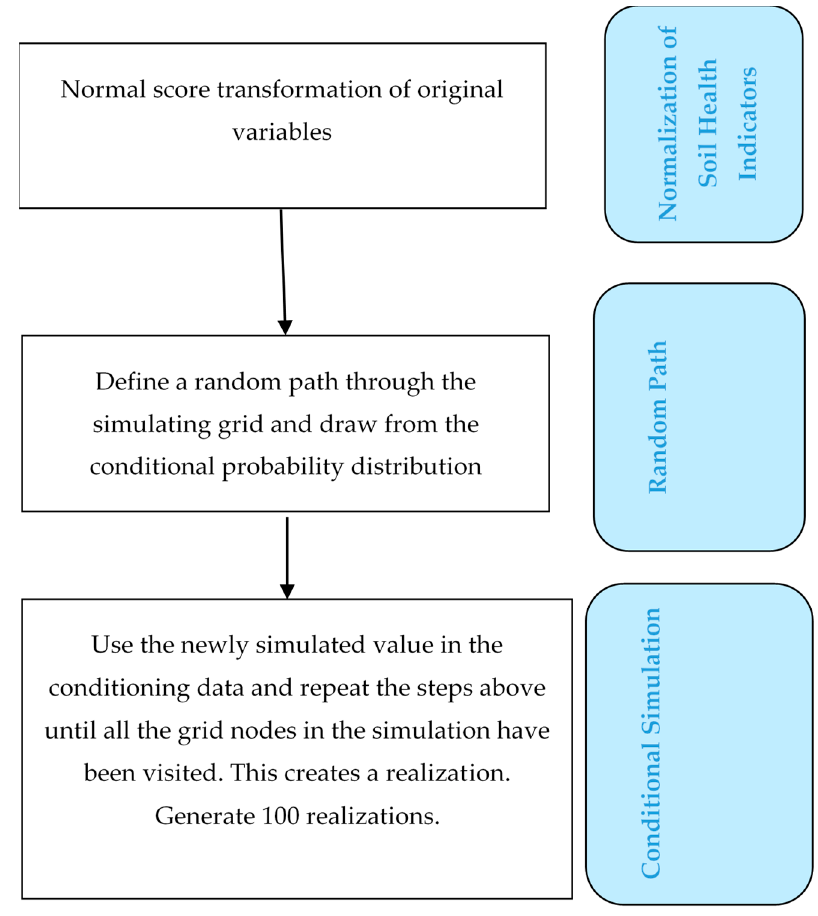
Figure 6. Workflow of conditional sequential Gaussian simulations.